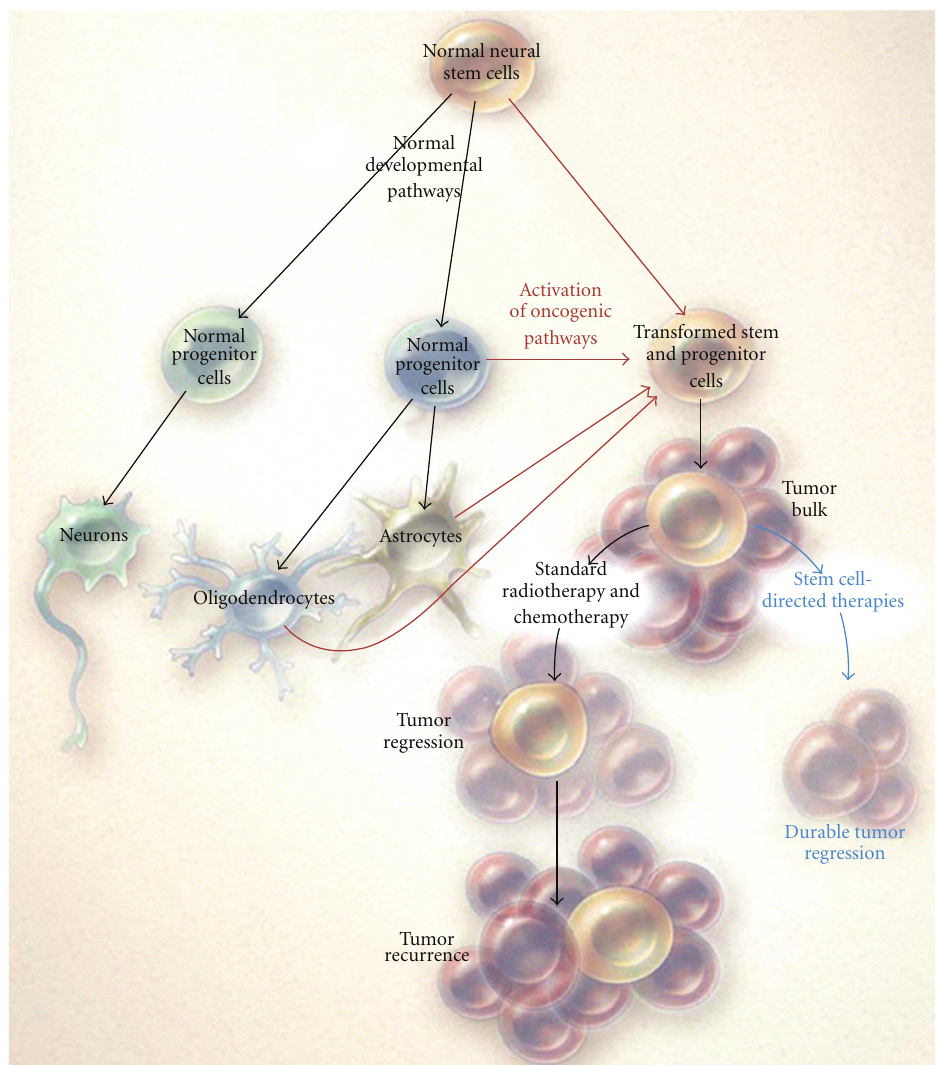
Figure 1: Resistance in GSC. Normal NSC self-renew and give rise to multipotential progenitor cells that form neurons, oligodendroglia, and astrocytes. GSC arise from the transformation of either NSC or progenitor cells (red) or, less likely, from de-di ff erentiation of oligodendrocytes or astrocytes (thin red arrows) and lead to malignant gliomas. GSC are relatively resistant to standard treatments such as radiation and chemotherapy and lead to regrowth of the tumor after treatment. Therapies directed at stem cells can deplete these cells and potentially lead to more durable tumor regression (blue) (from [60] with